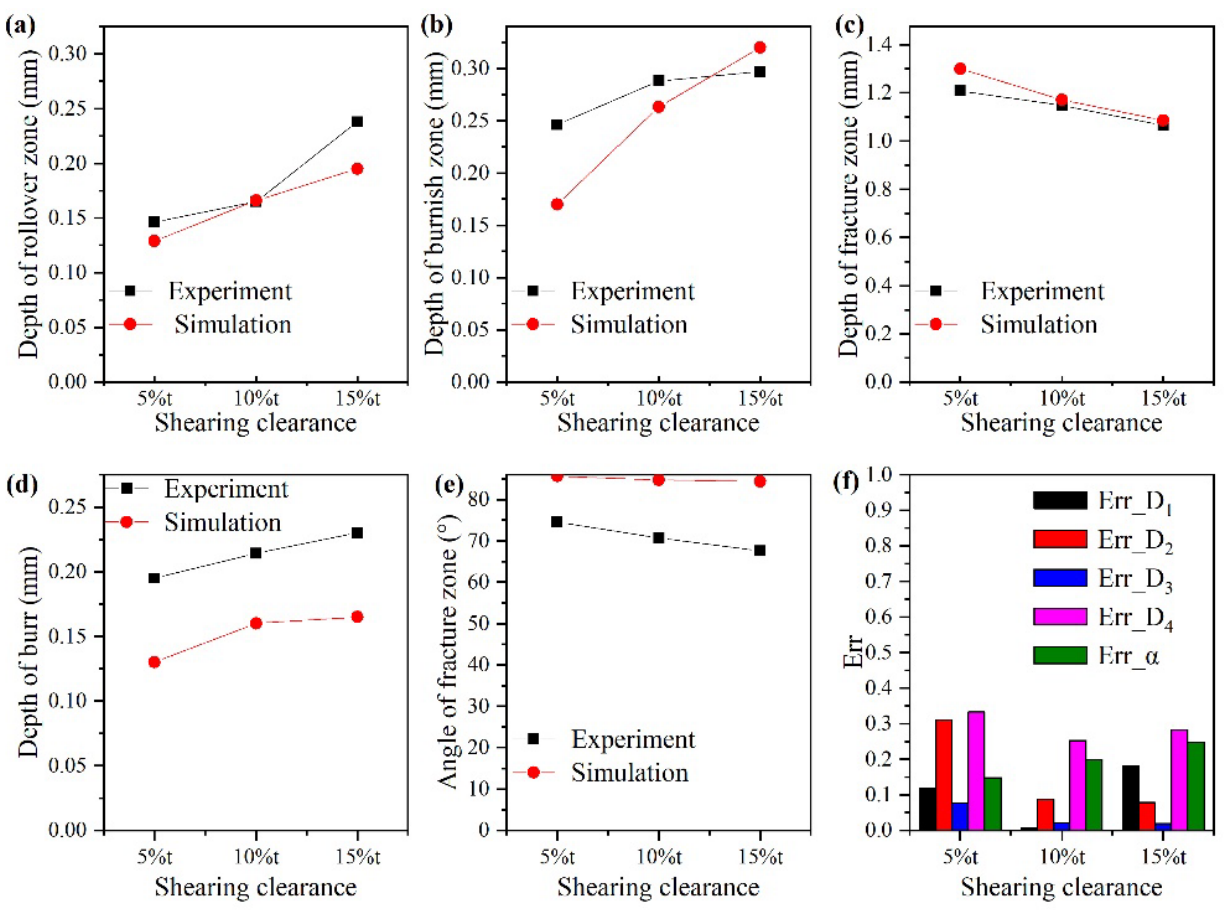
Figure 26. Analysis of simulation error. ( a ) Experiment and simulation results of rollover zone depth. ( b ) Experiment and simulation results of burnish zone depth. ( c ) Experiment and simulation results of fracture zone depth. ( d ) Experiment and simulation results of burr depth. ( e ) Experiment and simulation results of fracture zone angle. ( f ) Error calculation.